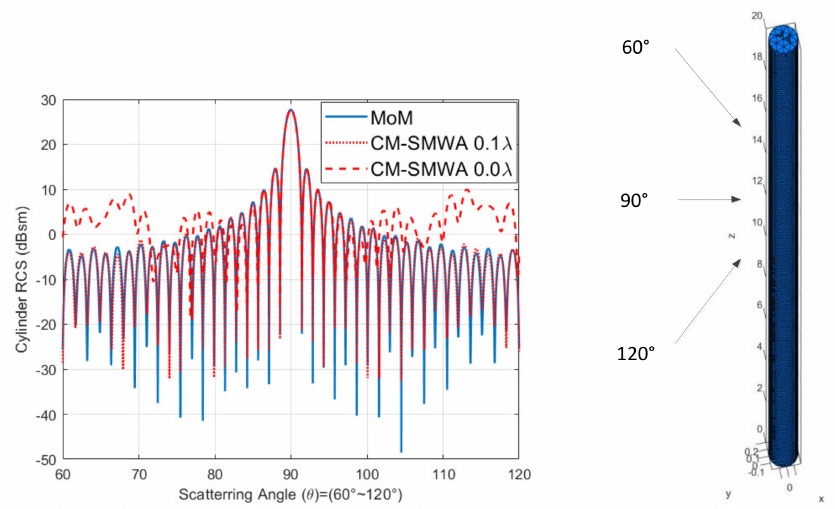
Figure 8. Calculation results of the RCS of cylinders under different expansion